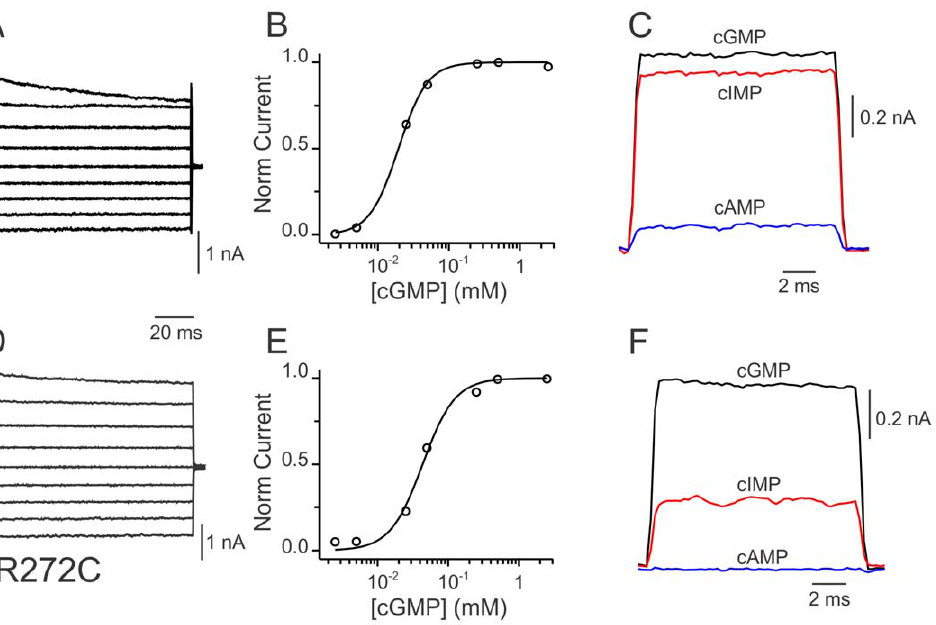
Figure 3. Functional characterization of CNGA1-GFP channels at the cell surface. A, B & C. Cysteine-less CNGA1-GFP channels. A, Ionic currents in the presence of saturating [cGMP] (2 mM). cGMP-activated currents shown were acquired in response to 100 ms voltage steps from 2 80 to + 80 mV (every 20 mV) from a holding potential of 0 mV. B. Dose response for cGMP at + 60 mV. Solid line represents a normalized Hill equation fit to the data. The best fit parameter values for K K was 19 6 1 m M, and for the hill coefficient (n) was 2.1 6 0.2. Average values for K K and n were 24 6 3 m M and 2.16 6 0.46, respectively (n=4 oocytes). C. Efficacies for different agonists. Wild type CNGA1 channels displayed larger than 95% maximal probability of opening with saturated concentrations of cGMP, less with cIMP, and much less with cAMP. Nucleotide-activated current records shown were obtained from the same excised inside out patch with saturating concentrations of cGMP (2 mM; black ), cIMP (16 mM; red ) and cAMP (16 mM; blue ). D, E & F. Rescued R272C CNGA1-GFP channels. D. Ionic current carried by MTSEA-modified R272C channels. In response to a comparable experimental protocol as in A, rescued channels were able to conduct ionic current with similar properties as wild type channels. E. Dose response of modified R272C channels at the cell surface for cGMP. Solid line corresponds to a normalized Hill equation fit to the data. The best fit parameter values for K K and n were 43.4 6 2.5 m M and 1.9 6 0.3, respectively. Average values for K K and n were 59 6 10 m M and 1.48 6 0.22, respectively (n=14 oocytes). F. Agonist efficacies for rescued R272C mutant channels. Nucleotide-activated current records shown were acquired